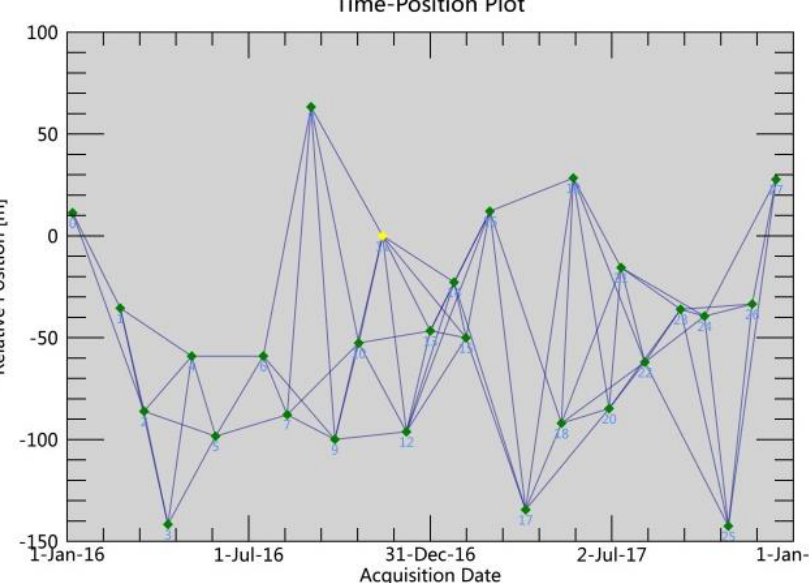
Figure 3. Spatial-temporal baselines of the generated interferograms using SBAS-InSAR （ each dot represents an interferogram ） .